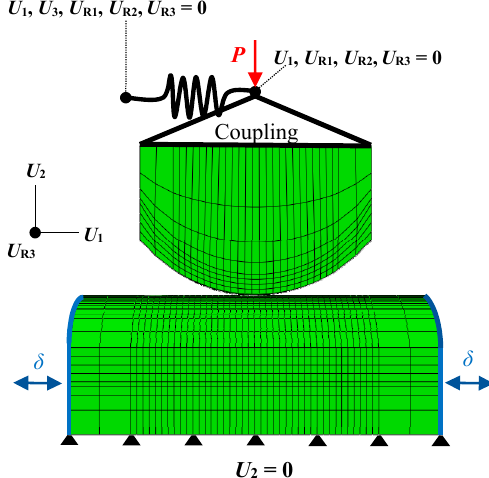
Figure 6. FE loading and boundary conditions in the 3D fretting steel wires model.